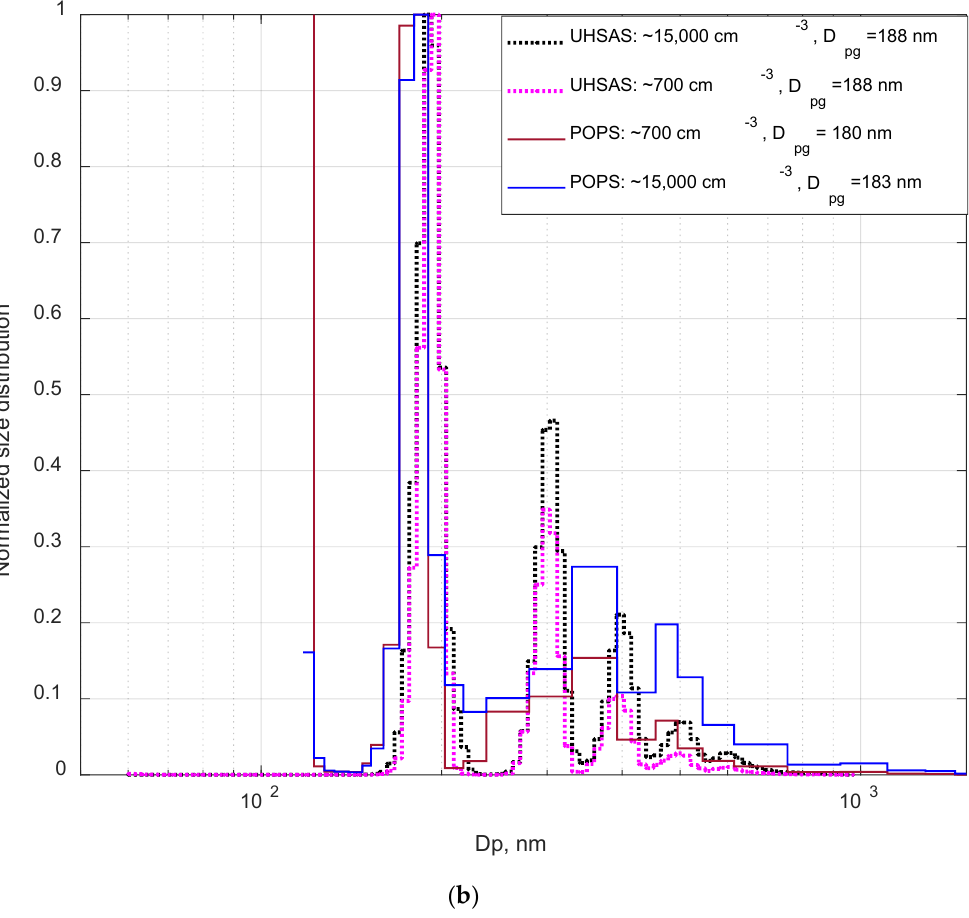
Figure 3. ( a ) The measured aerosol concentration comparison between Scanning Mobility Particle Spectrometer (SMPS), Ultra-High Sensitivity Aerosol Spectrometer (UHSAS), and POPS; the aerosol total number concentration effects on the ( b ) the normalized size distribution from POPS and UHSAS (using the 200 nm size-selected ammonium sulfate aerosols).